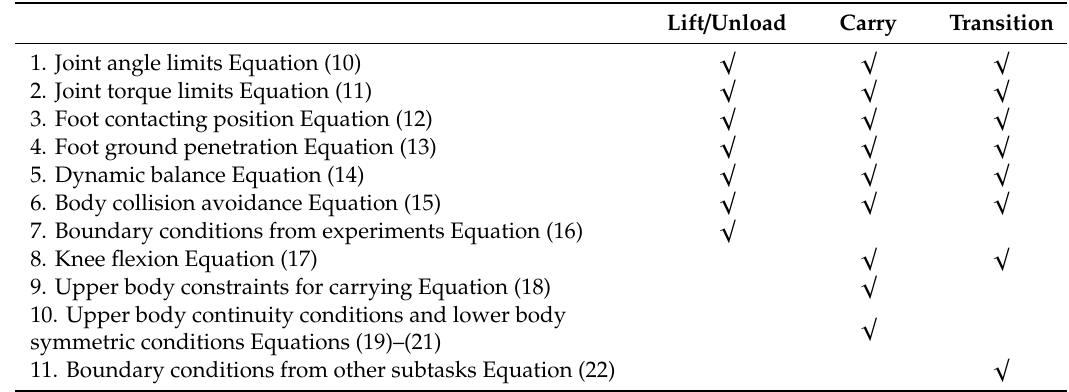
Table 1. Constraints for